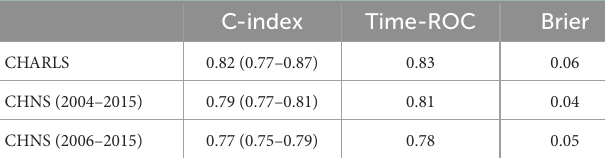
TABLE 4 Performance of the predictive model on the external validation